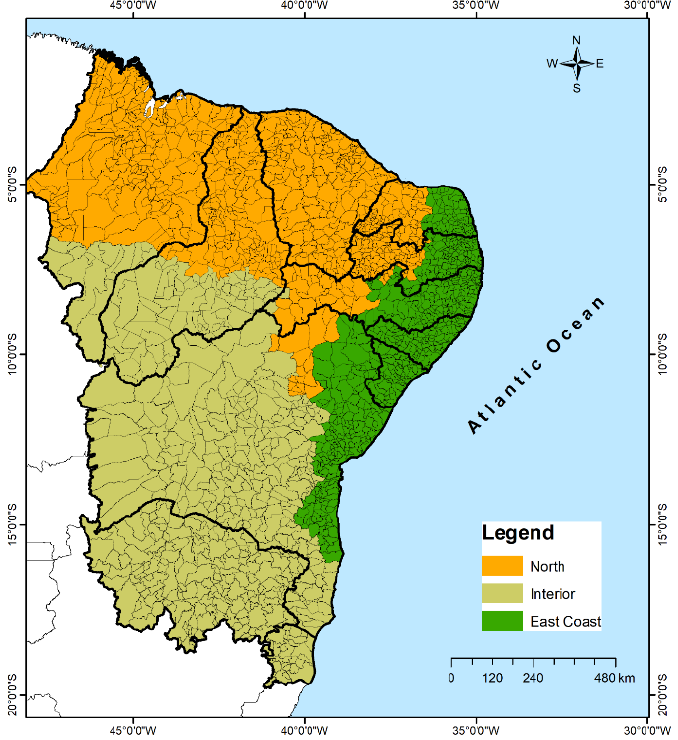
Figure 1. Northeastern Brazil and the three subregions used in this study: East Coast, Interior, and North.